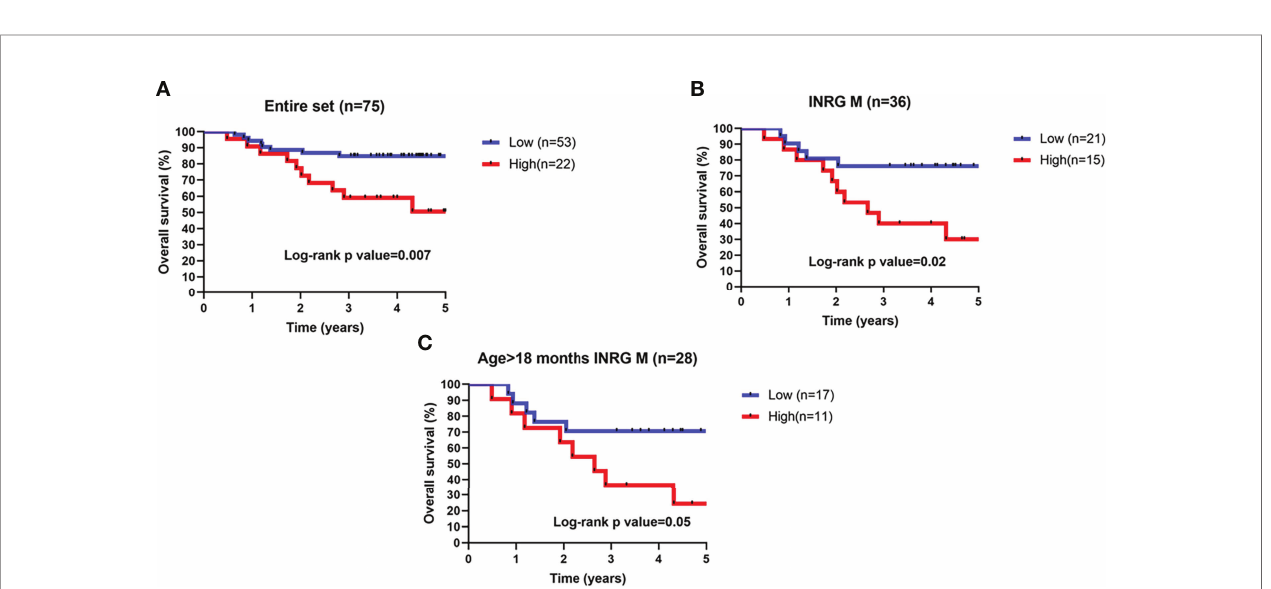
FIGURE 6 | Kaplan – Meier estimates and signi fi cance of NB patient OS by 3-O-Methyldopa expression. Kaplan-Meier curves show OS of NB patients with high (red) or low (blue) 3-O-Methyldopa expression in a time interval of 5 years. OS is displayed in years. To enhance reliability, data include alive patients with at least 3-years of follow-up. Low or high 3-O-Methyldopa expression was determined according to a cutoff of 454.9 determined with the Elbow method for the second dataset. Plots are relative to (A) All patients, (B) , stage M tumors and (C) high-risk patients older than 18 months with stage M tumor. Plots are entitled with the characteristics of the patients in the sub-population. Survival curves were compared by log-rank test. The number of patients with low or high 3-O-Methyldopa expression is reported within brackets in the